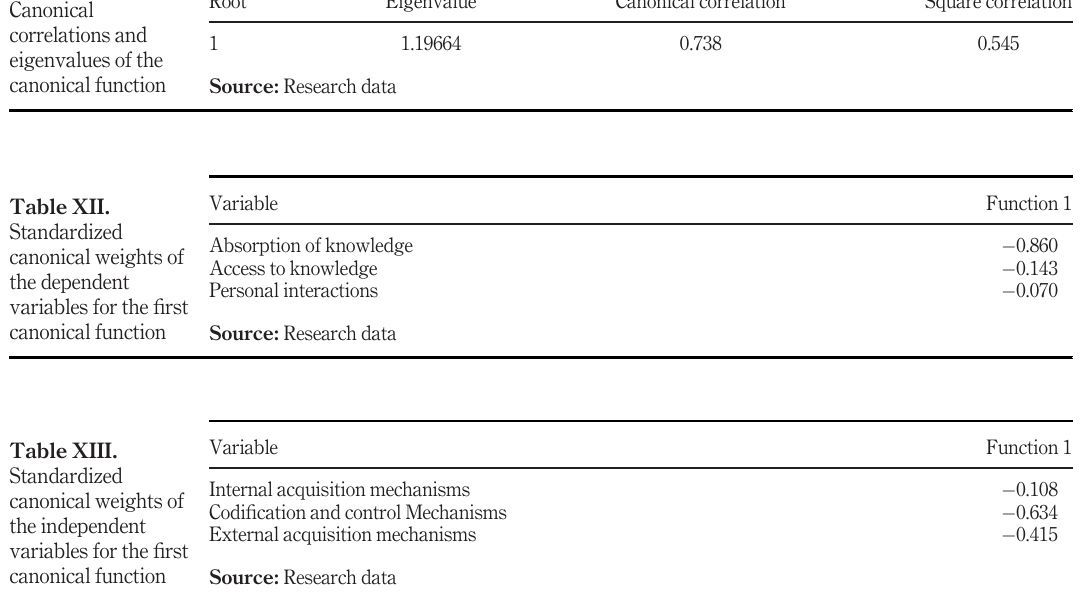
Table XI. Canonical correlations and eigenvalues of the canonical function